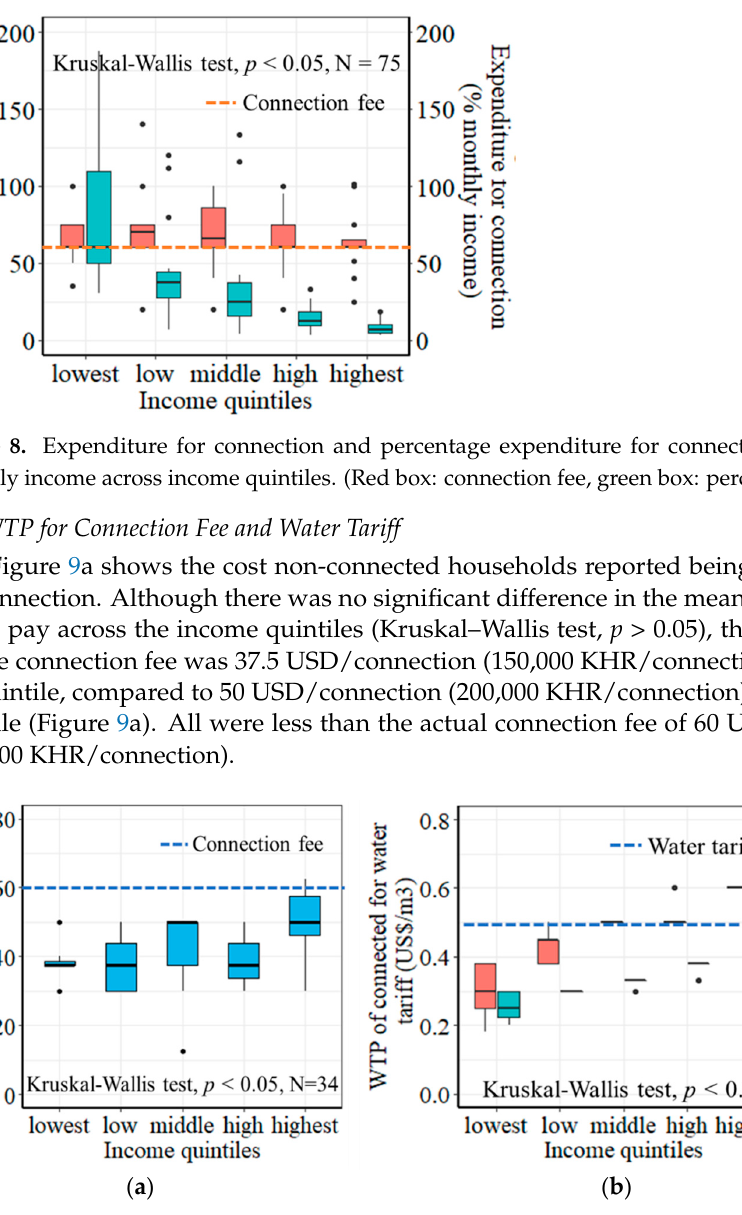
12 of 19 Figure 7. Correlation between log monthly income and percentage of household expenditure on piped or bottled water.